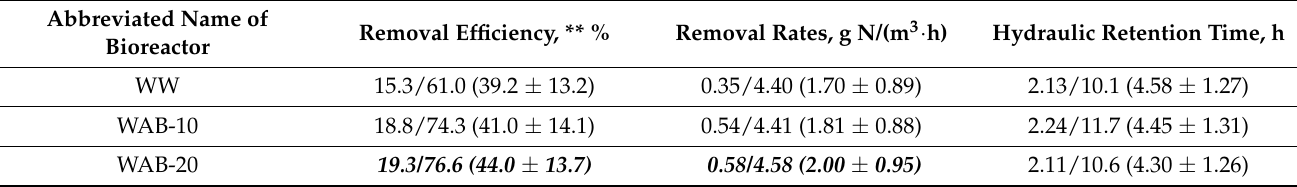
Table 1. Efficiencies and rates of NO 3 -N removal in bioreactors *.